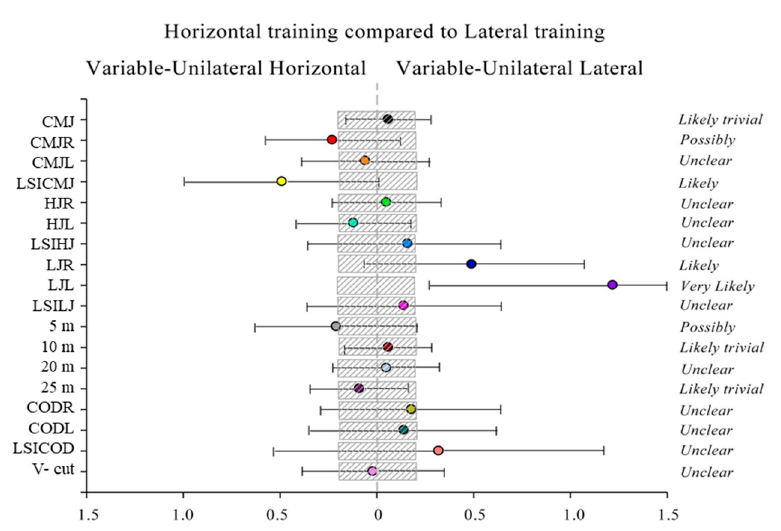
Figure 3. Efficiency of variable unilateral horizontal training (VUH) compared to that of the variable unilateral lateral (VUL) training program to improve bilateral countermovement jump performance (CMJ), vertical jump with the right (CMJR) and left leg (CMJJL), the between-legs asymmetry in vertical jumping (LSICMJ), horizontal jump with the right (HJR) and left leg (HJL), the between-legs asymmetry in horizontal jumping (LSIHJ), lateral jump with the right (LJR) and left leg (LJL), the between-legs asymmetry in lateral jumping (LSILJ), 5, 10, 20 and 25 m linear sprint time, a sprint of 10 m (5 + 5 m) with the right (CODR) and left leg (CODL) with a change of direction of 180°, the between-legs asymmetry in 180° change of direction (LSICOD) and a 25 m sprint with 4 changes of direction of 45° (V-cut) (the bars indicate uncertainty in the true mean changes with 90% confidence limits). Trivial areas were the smallest worthwhile change (SWC) (see Section 2).